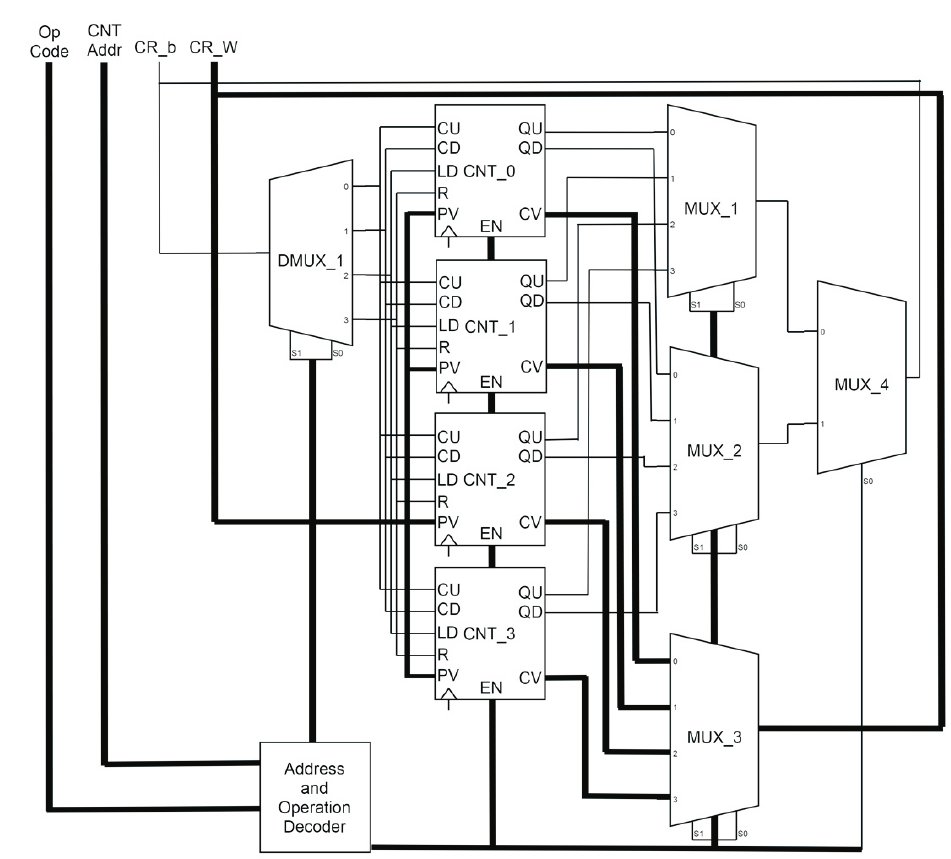
Figure 10. The structure of the counter function block for four